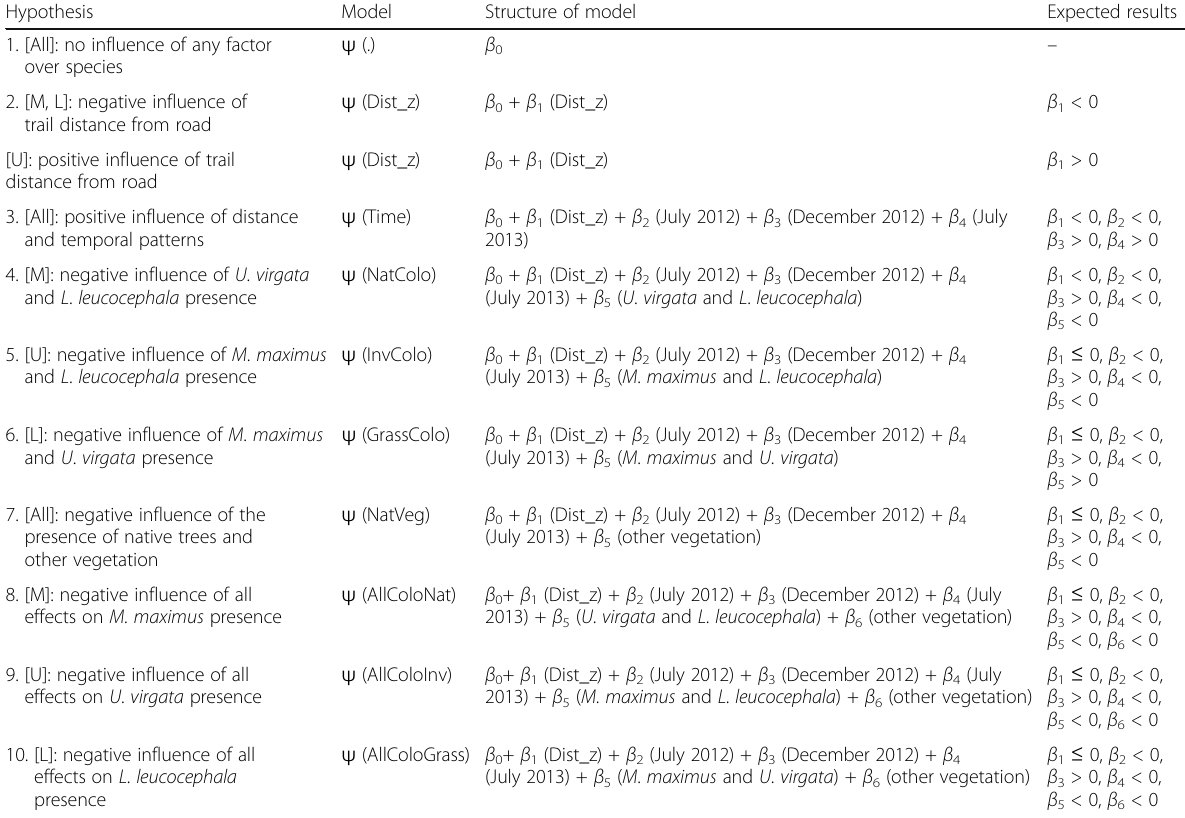
Table 1 Descriptions and expected direction of occurrence probability ( ѱ ) models for Megathyrsus maximus [M], Leucaena leucocephala [L], and Uniola virgata [U] along the 570-m bulldozed trail in the Ensenada sector of the Guánica Forest. All models tested for significance at α =